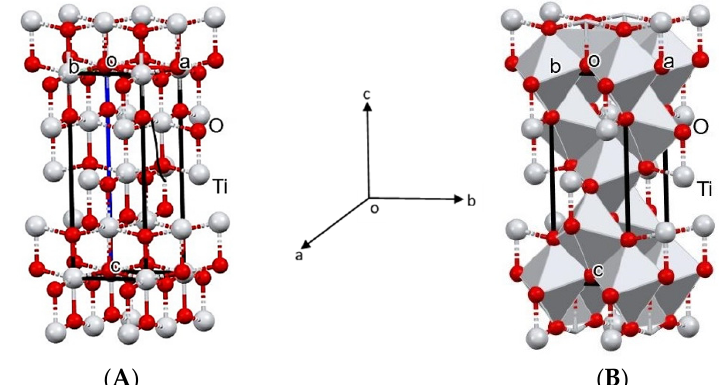
Figure 6. Crystal structure of anatases TiO 2 nanoparticle in unit cells with ( A ) ball stick and ( B ) polyhedron patterns. a, b,c and o is the notation of the three-dimensional coordinate system contains an origin (o) and formed by three mutually perpendicular coordinate axes: the x-axis (a), y-axis (b), and the z-axis (c).